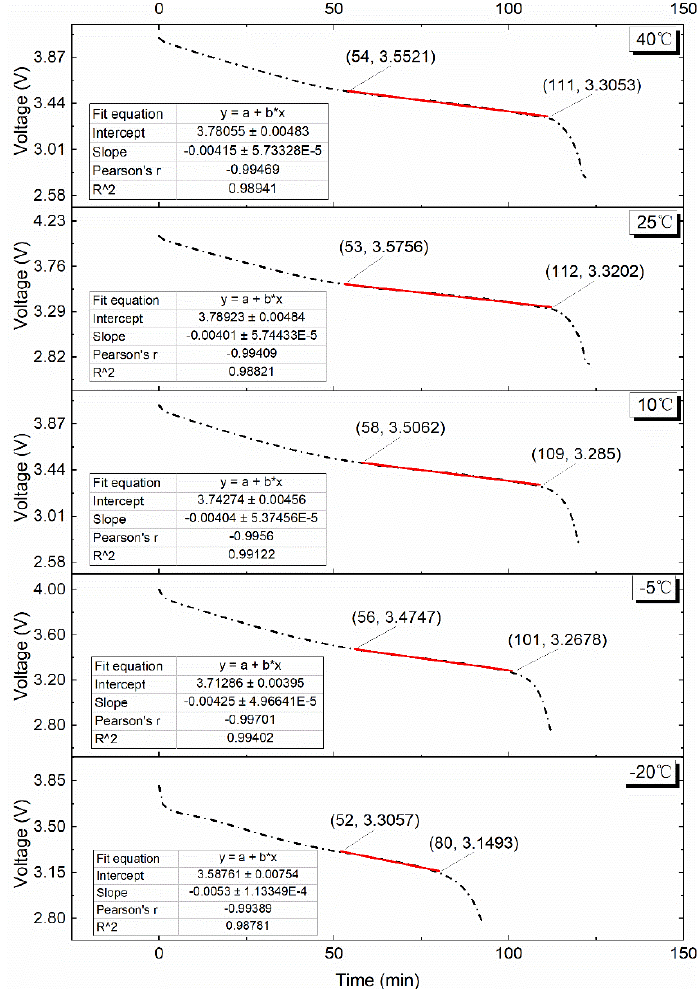
Figure 11. Influence rule of different ambient temperatures on voltage plateau period during 0.5C discharge.